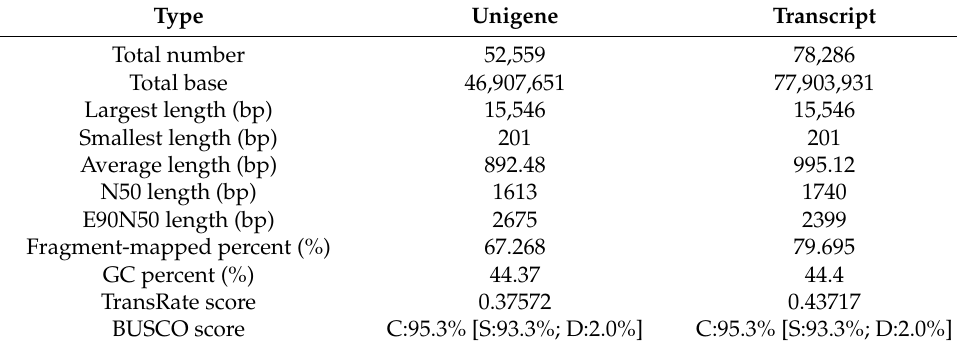
Table 2. Statistical table of assembly-result evaluation.